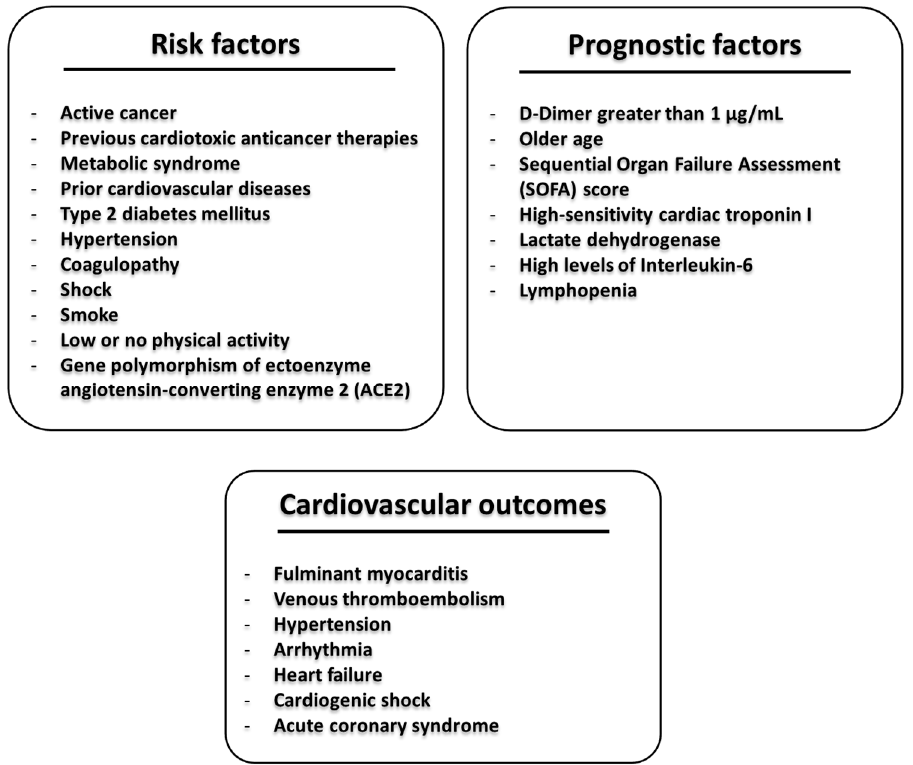
Figure 1. Cardiovascular adverse outcomes in patients with cancer during Severe Acute Respiratory Syndrome coronavirus 2 (SARS-CoV-2) infection are exacerbated by four interrelated risk factors: cancer itself, which causes immunosuppressive effects; cardiotoxic, pro-fibrotic, and pro-inflammatory anticancer therapies; history of cardiovascular diseases (hypertension, coronary heart disease, or diabetes); direct cardiac effects of SARS-CoV-2 infection.